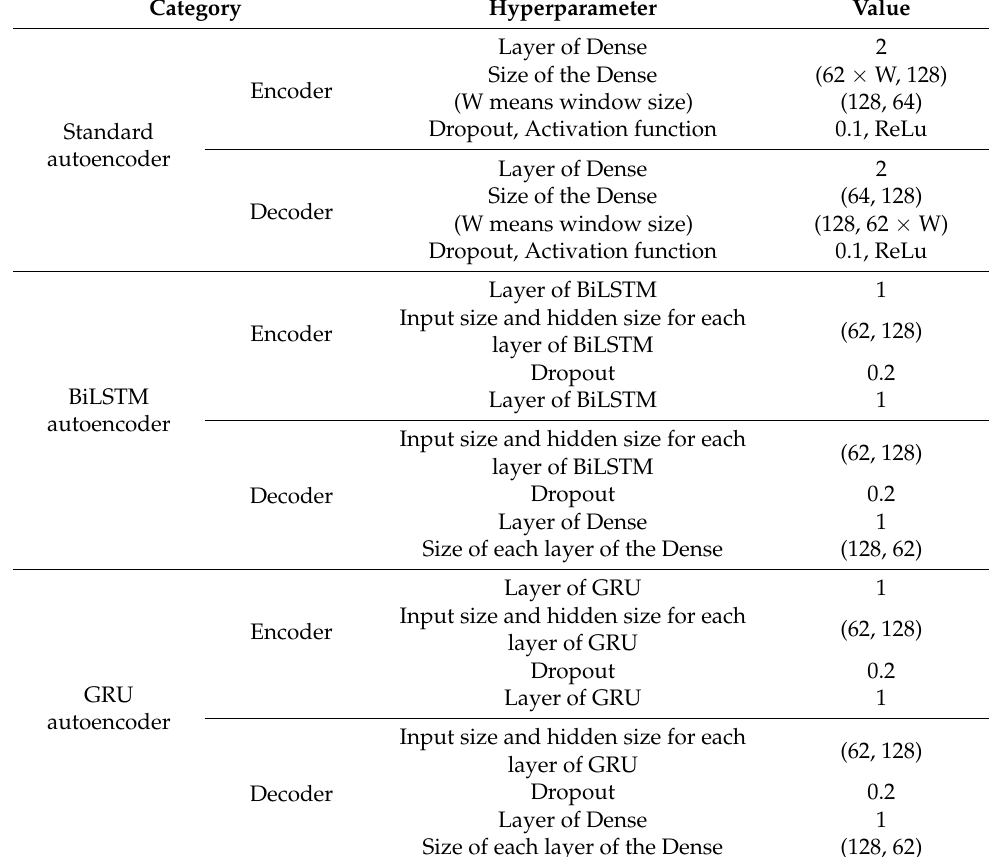
Table 9. Three autoencoder